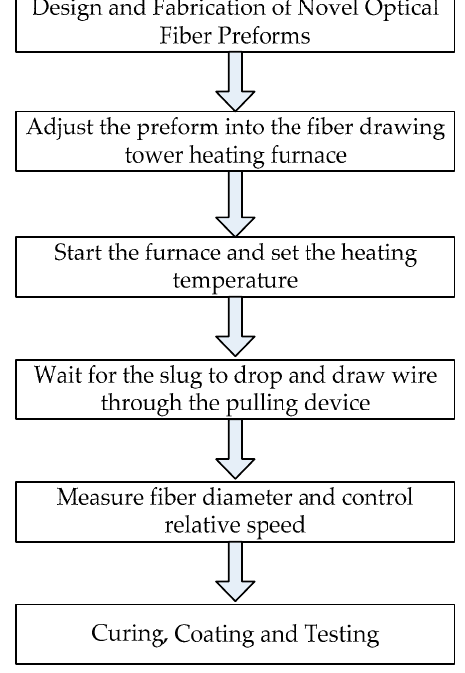
Figure 1. Schematic diagram of new optical fiber manufacturing. Table 1. Parameters of novel high temperature resistant doped fiber.